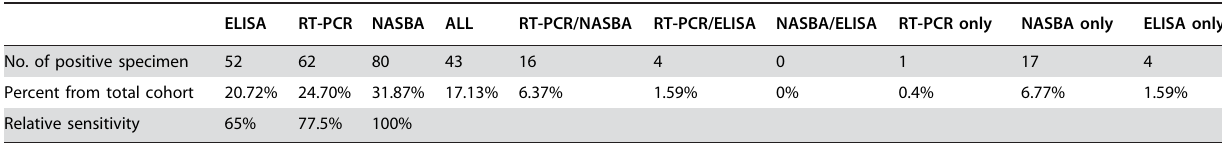
Table 1. Overview on the comparison of three diagnostic procedures for the detection of RSV .. ... .... ... ... .... ... ... .... ... ... .... ... ... .... ... ... .... ... ... .... ... ... .... ... ... .... ... ... .... ... ... .... ... ... .... ... ... .... ... ... .... ... ... .